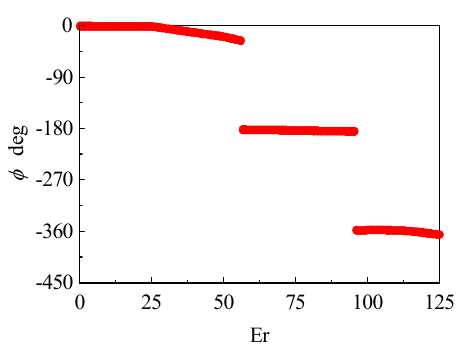
Fig.13 Effect of Er on the director angle at the upper plate for Ae=100